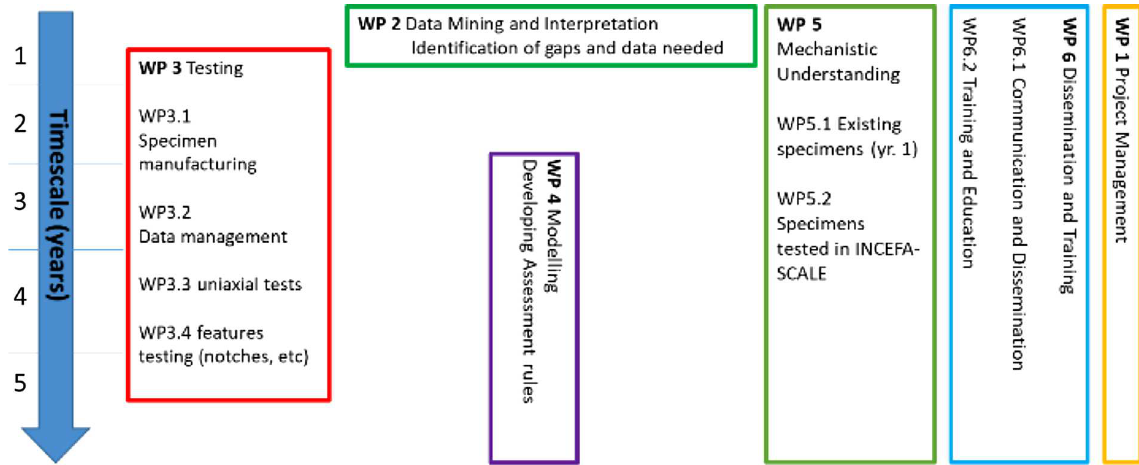
Fig. 3. INCEFA-SCALE work package structure plus timescales for WP